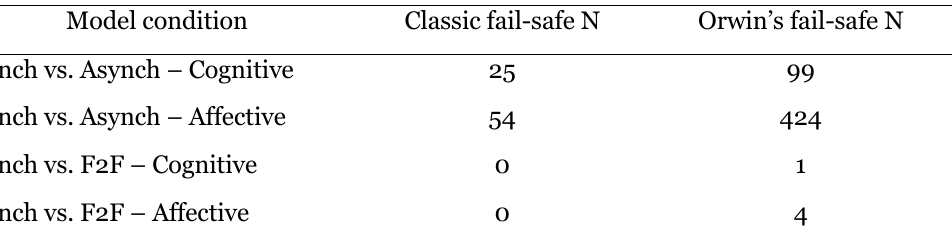
Classic Fail-Safe N and Orwin’s Fail-Safe N for Each Model Model condition Classic fail-safe N Synch vs. Asynch – Cognitive